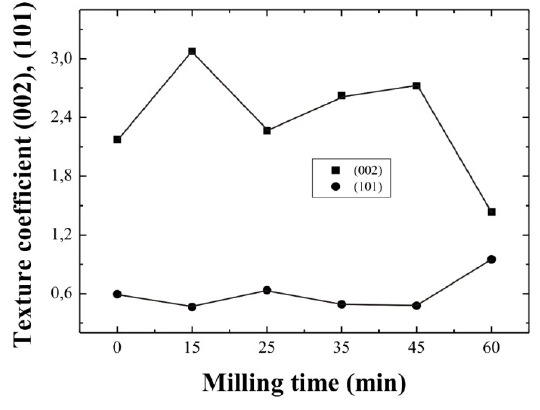
Figure 3. Dependence of the texture coefficient of ZnO:Al thin films on the milling time of the starting precursors.